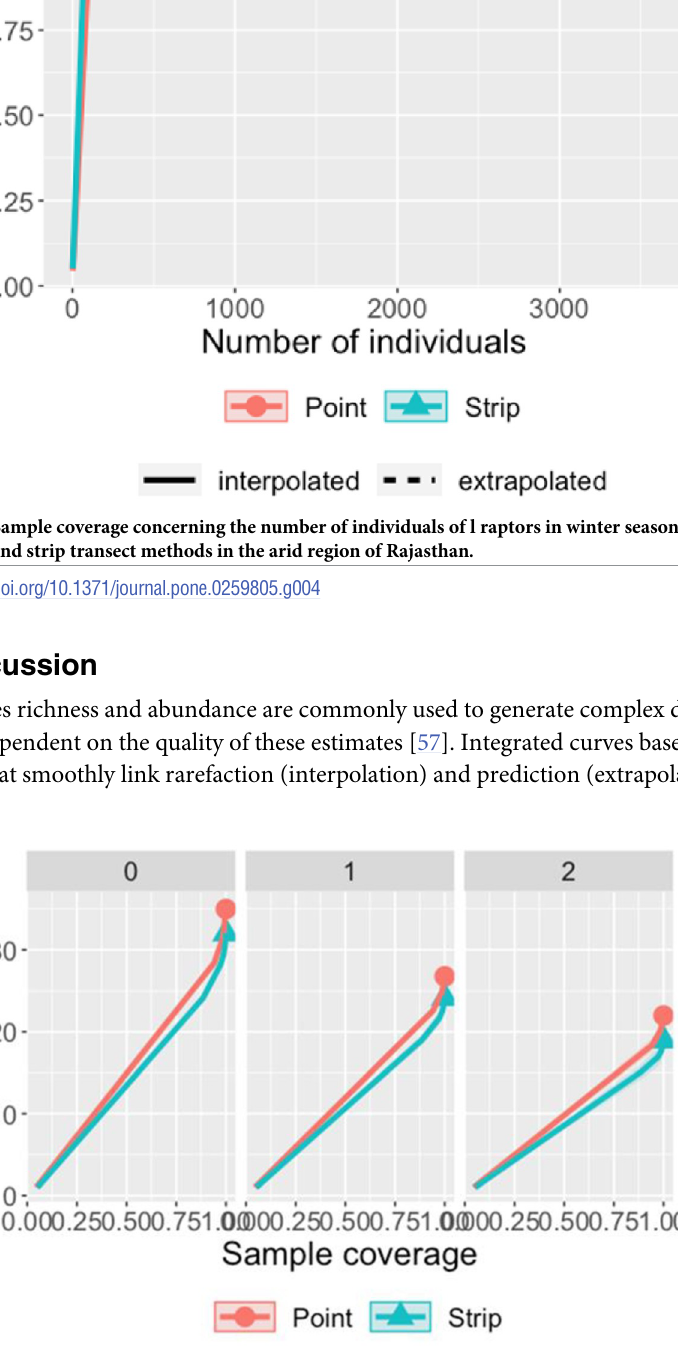
PLOS ONE | https://doi.org/10.1371/journal.pone.0259805 December8,